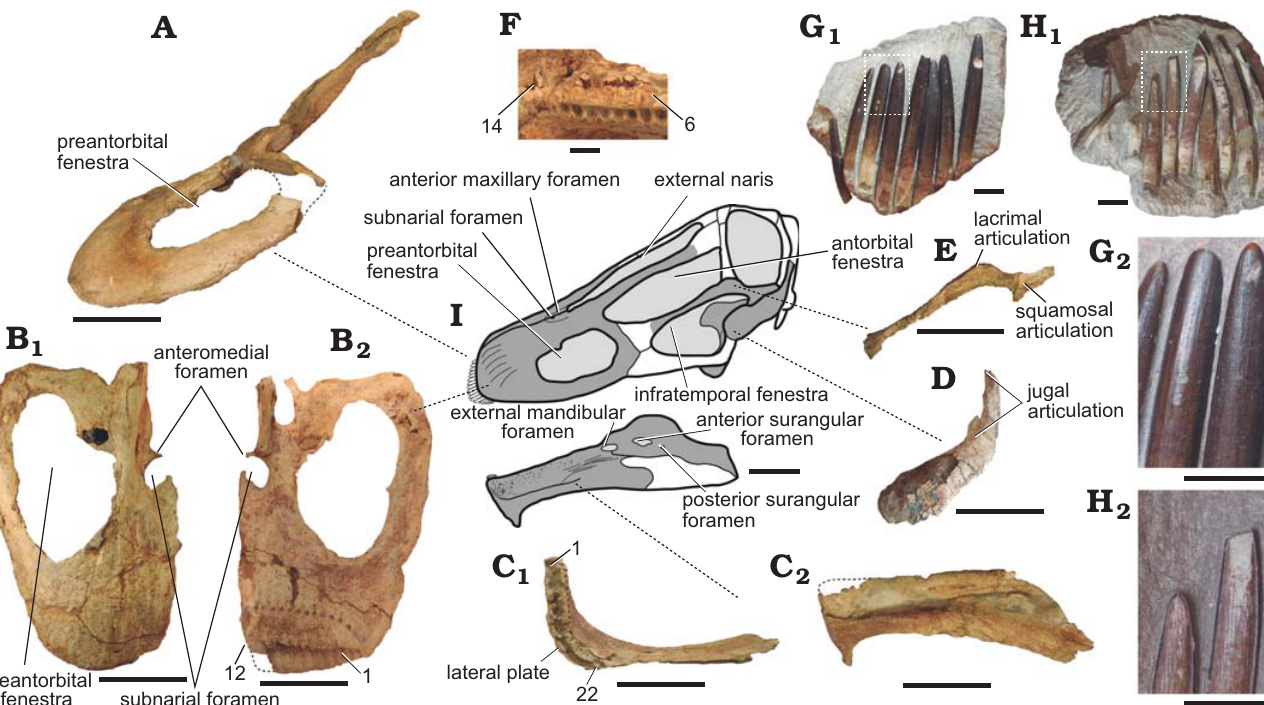
Fig. 3. Rebbachisaurid sauropod Lavocatisaurus agrioensis gen. et sp. nov. from Agrio del Medio (Argentina), Aptian–lower Albian. A . Left maxilla in lateral view. B . Right maxilla in anterodorsal (B 1 ) and posteroventral (B 2 ) views, numbers indicate the tooth positions. C . Left dentary in dorsal (C 1 ) and lateral (C 2 ) views, numbers indicate the tooth positions. D . Right squamosal (inverted) in lateral view. E . Right jugal (inverted) in lateral view. F . Dentary teeth, numbers indicate the tooth positions. G . Eight associated teeth in labial view (G 1 ), close up of two teeth in labial view (G 2 ), showing the absence of wear facets. H . Nine associated teeth in lingual view (H 1 ), close up of the teeth in labial view (H 2 ), showing the wear facets. I . Skeletal reconstruction, based on the holotype MOZ-Pv1232. Scale bars: A–E, 10 cm; F–H, 1